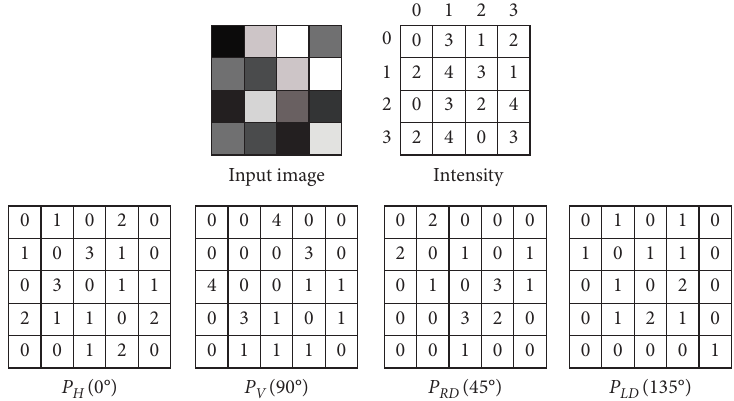
� 5 levels and 4 dissimilar g